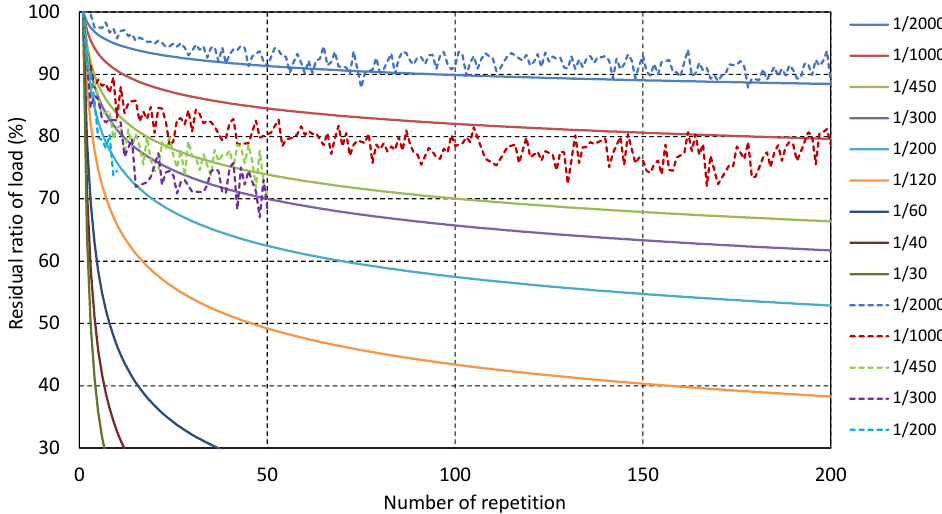
Figure 7. Relationship between deformation and slope of regression line. (Gypsum board).